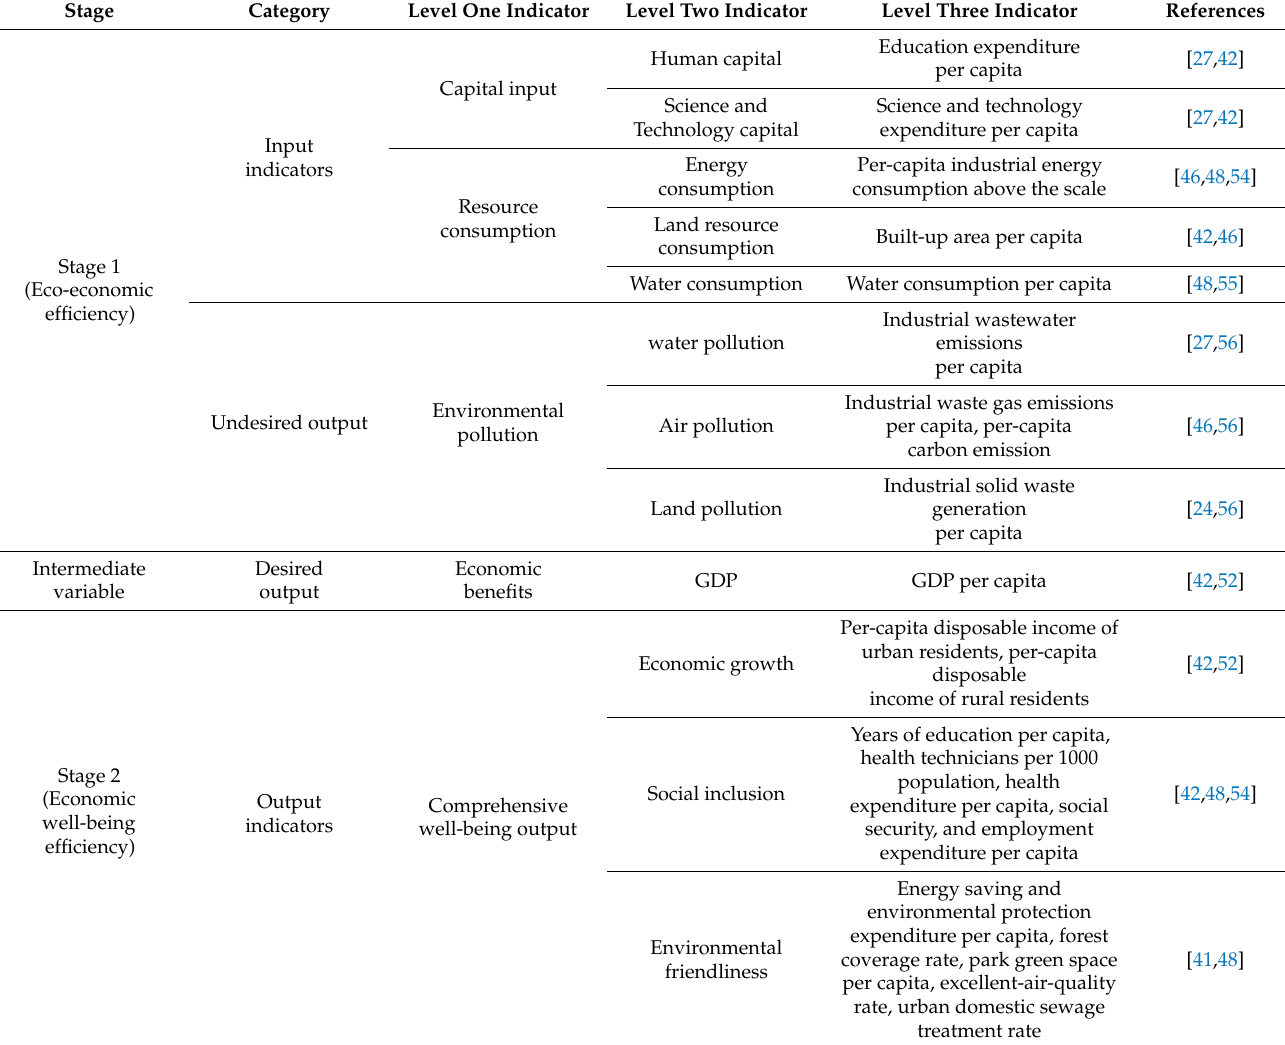
Table 1. Evaluation index